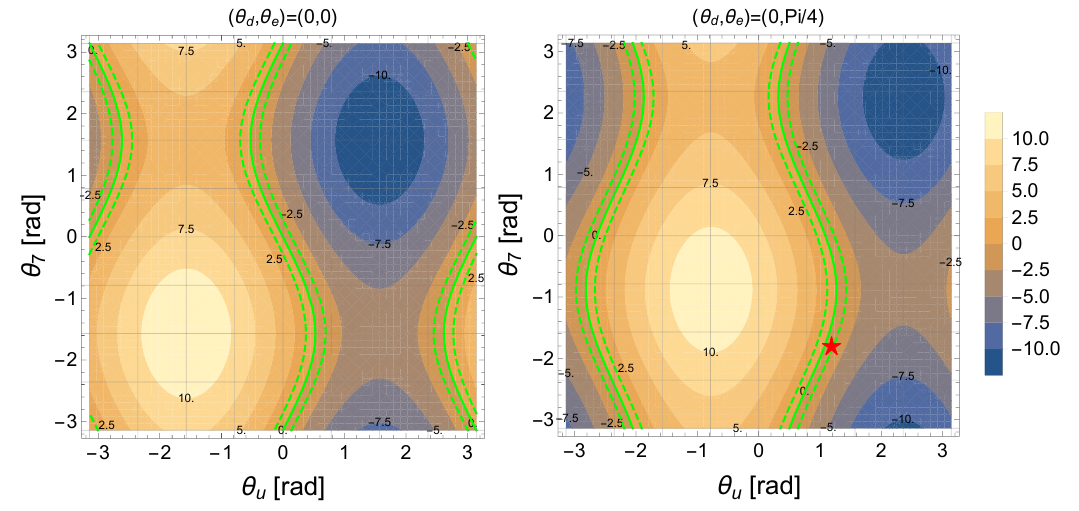
Figure 3 . Contour plot for the electron EDM d e in the unit of 10 (cid:0) 29 e cm as a function of (cid:18) u and (cid:18) 7 in the case with m = 280, m = 230, j (cid:21) 7 j = 0 : 3, j (cid:16) u j = 0 : 01, j (cid:16) d j = 0 : 1 and j (cid:16) e j = 0 : 5. The H (cid:6) H 0 2 left (right) panel corresponds to the case with (cid:18) d = 0 and (cid:18) e = 0 ( (cid:25)= 4). The green solid lines denote d e = 0 and the area between the green dashed lines is the allowed region against the constraint from the electron EDM. In the right panel, the point marked by the star ( (cid:18) u ; (cid:18) 7 ) = (1 : 2 ; (cid:0) 1 : 8) is the benchmark